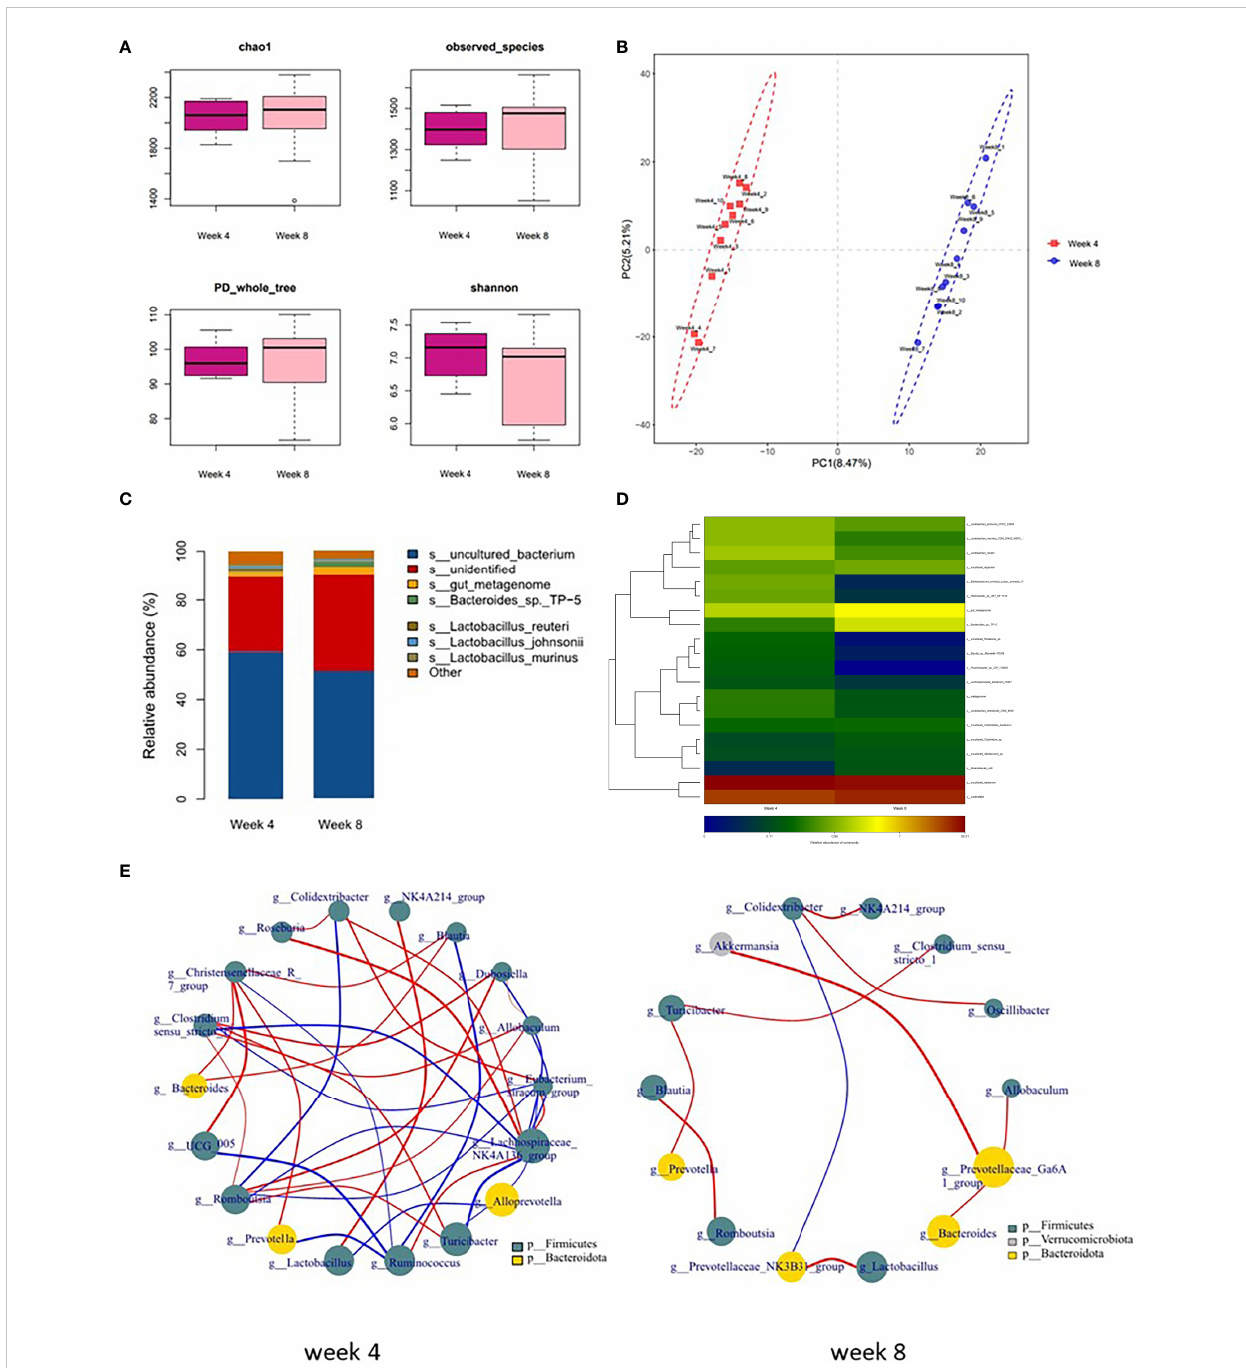
FIGURE 3 Microbial composition in long-term depression and co-occurrence of the species . (A) a -phylogenetic diversity analysis of 4-week CUMS and 8- week CUMS rats. (B) OPLS-DA showed that the gut microbial composition of 8-week CUMS rats was signi fi cantly different from that of 4-week CUMS rats. (C) Relative abundance of gut microbes at the species level. (D) Altered species (top 20) in the long-term depression group. (E) Co- occurrence of the species altered in the depression groups at the g and p